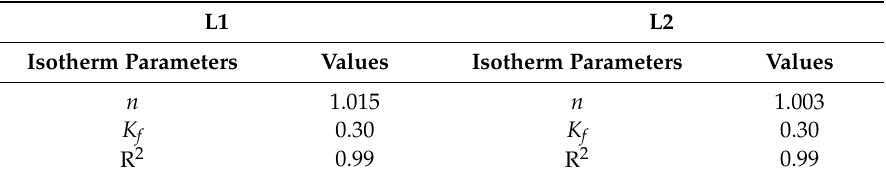
Table 2. Freundlich isotherm data for the two types of